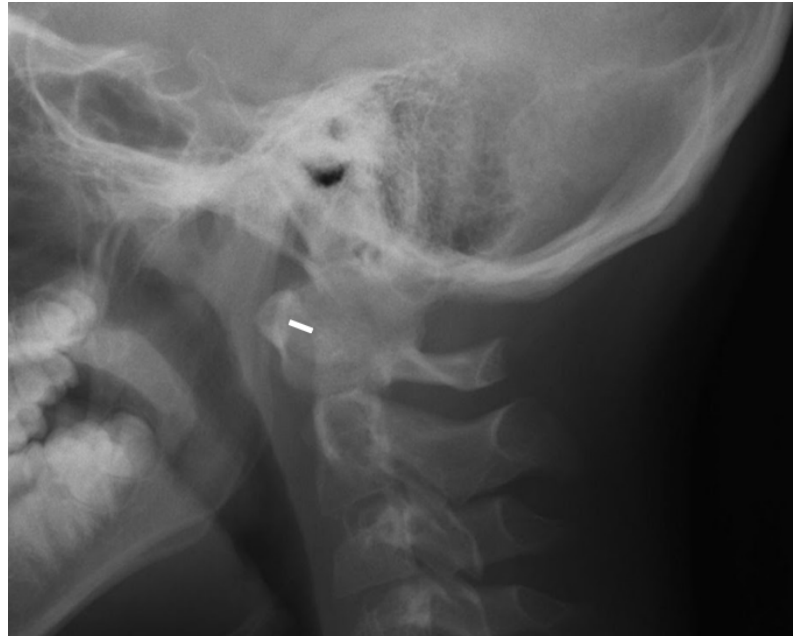
Figure 3. Lateral radiograph in neutral position in a 12-year-old boy (the same patient as in Figure 2) showing anterior atlantoaxial subluxation 6 mm (white line). Several methods were used to measure vertical subluxation; the most frequently used methods were McGregor’s (cut off value: 4.5 mm) [13] or the Sakaguchi–Kauppi method.